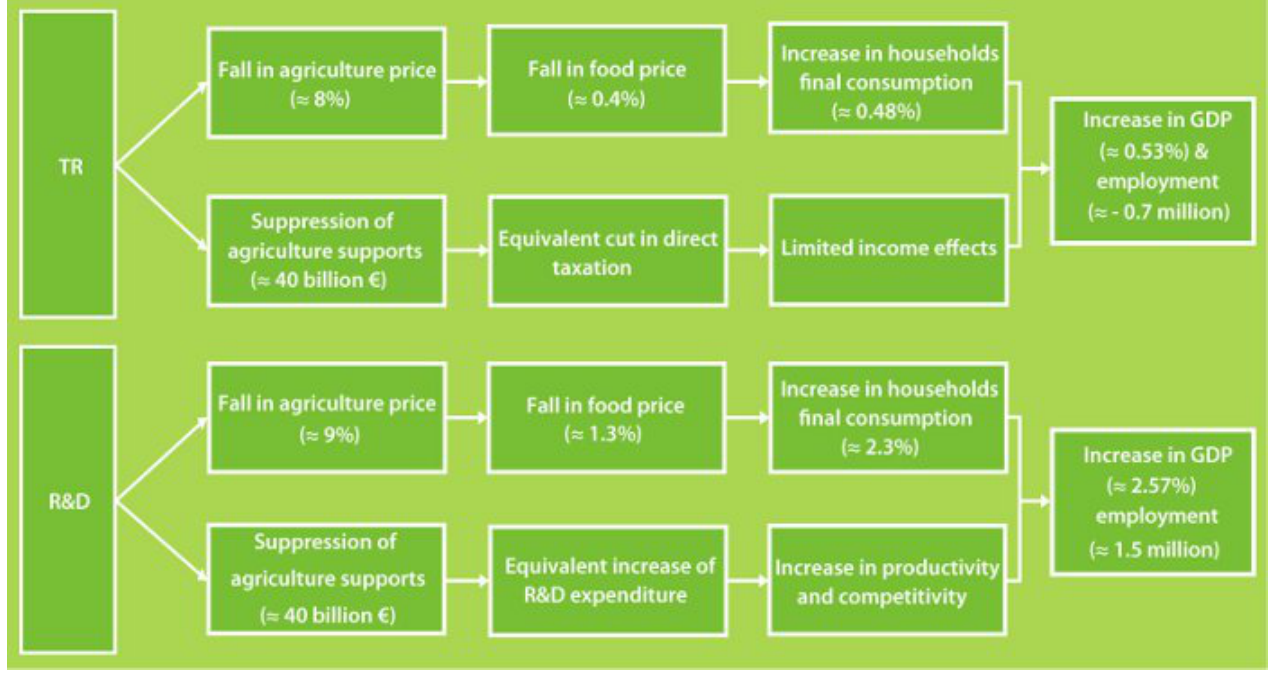
Fig. 5 . Common Agricultural Policy financial reform scenario: 100% cut of Common Agricultural Policy first pillar measures (market support and direct income support), and re-investment of savings in research and development. Simulated comparison of effects of tax rebate (TR) on GDP compared to re- investment in research and development